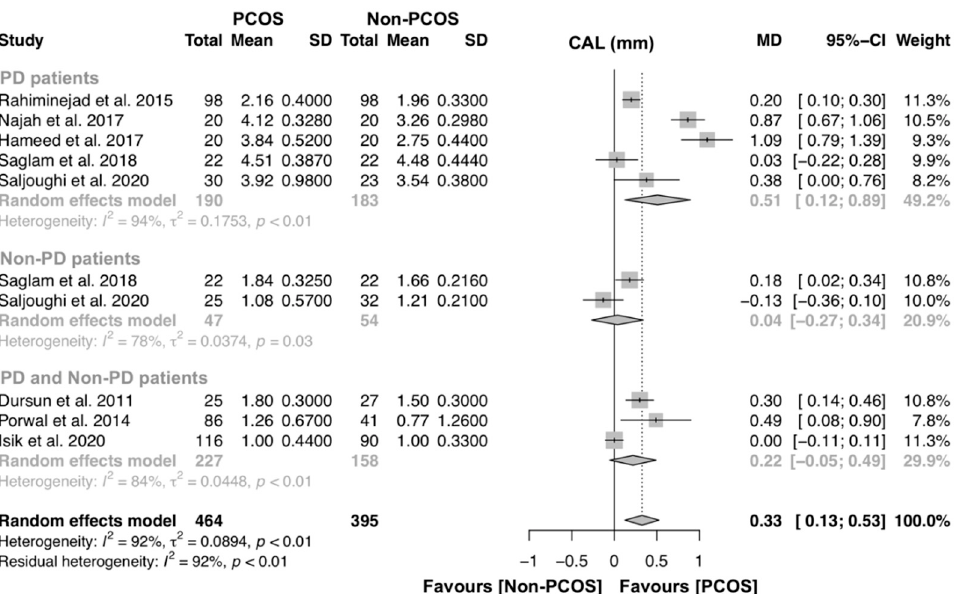
Figure 6. Forest plot of studies evaluating clinical attachment loss (CAL) levels in PD patients with and without PCOS (p-value = 0.0014). Mean e ff ect size estimates have been calculated with 95% confidence intervals and are shown in the figure. Area of squares represents sample size, continuous horizontal lines and diamonds width represents 95% confidence interval. Diamond and the vertical dotted line represent the overall pooled